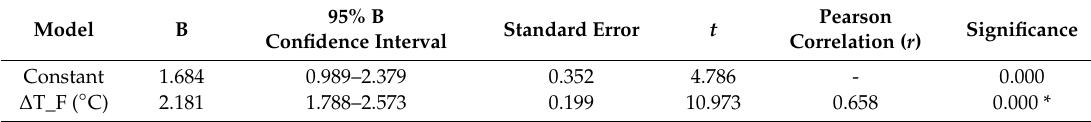
Table 10. Regression analysis using as independent variable: forearm skin temperature variation ( ∆ T_F).